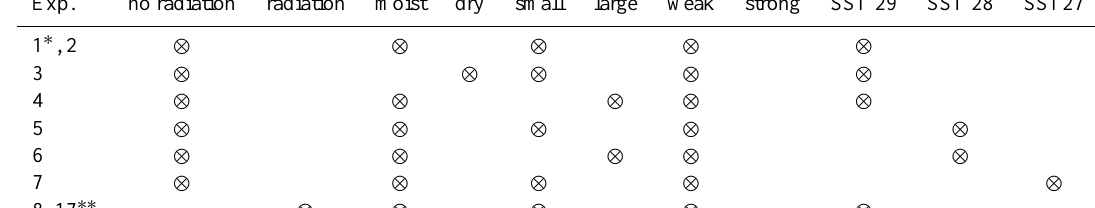
Table 1. Experiments 1–16 categorized by either no radiation, or radiation included; moist, or dry; small, or large; weak, or strong; value of SST is either 29, 28, or 27 ◦ C. Exp. no radiation radiation moist dry small large weak